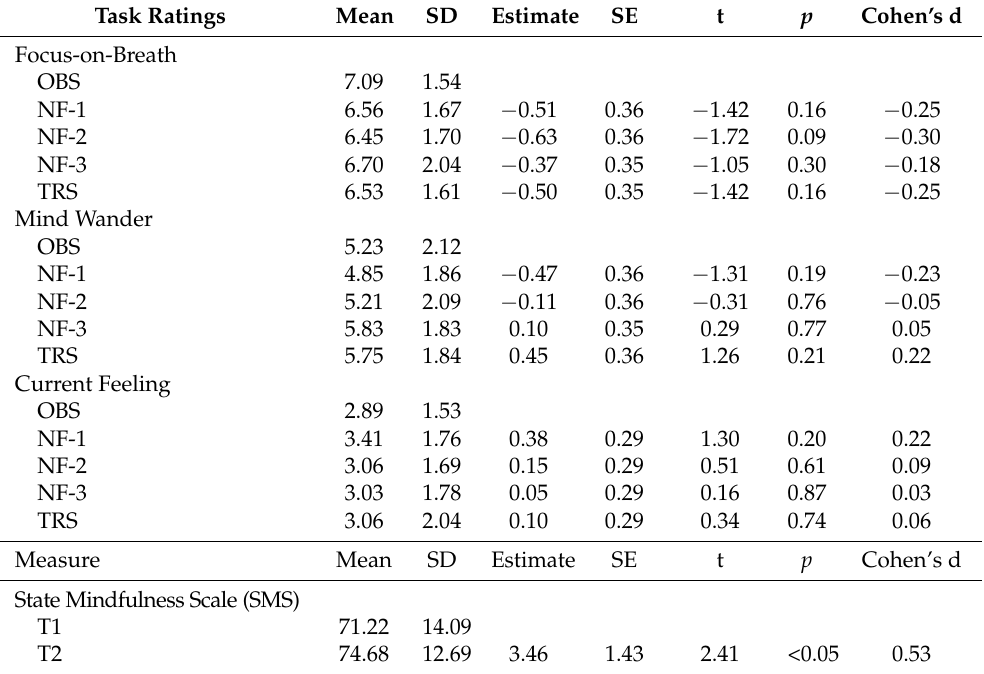
Table 2. Unadjusted means, standard deviations, effect sizes, and main analyses of task ratings and symptom